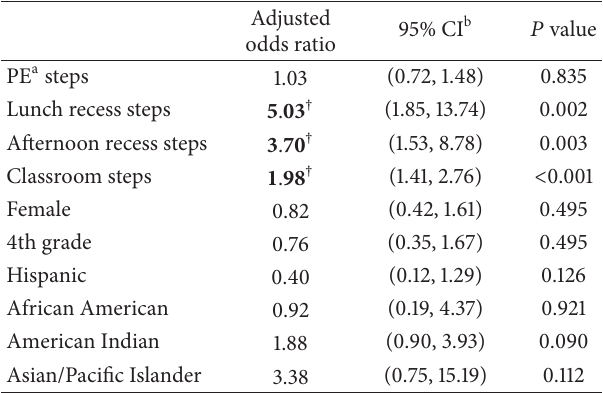
Table 3: Parameter estimates from the final fixed effects model solution using the daily step target criterion (12,000 steps).